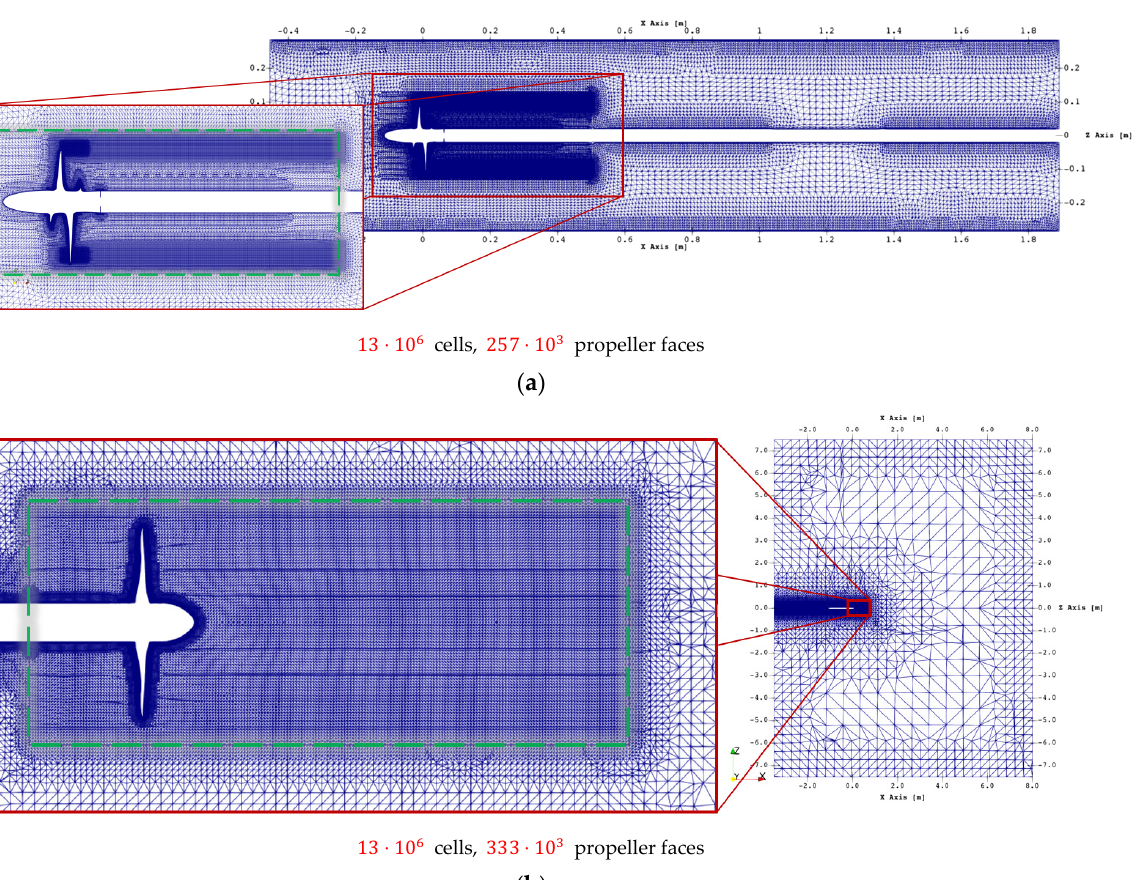
Figure 1. Initial mesh: ( a ) Newcastle; ( b ) P1595.